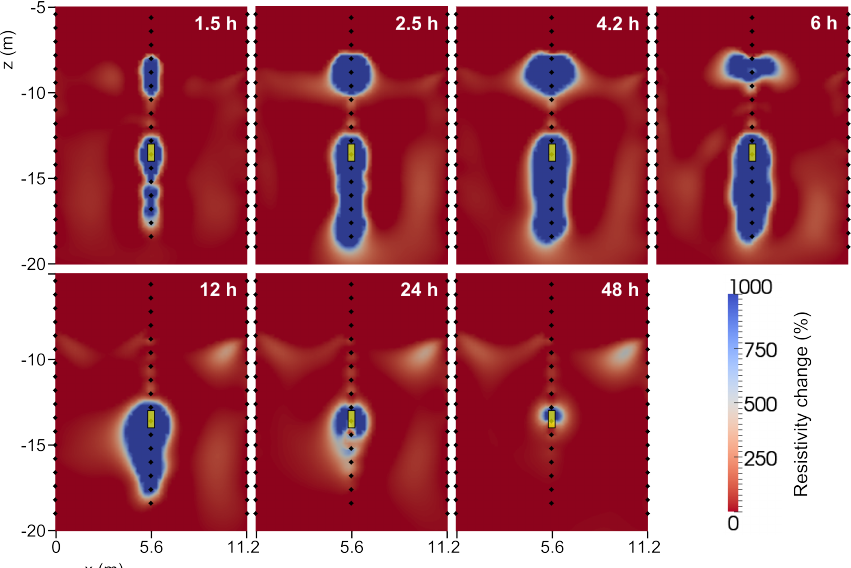
Figure 12. Results of synthetic ERT experiment for selected times (in hours after start of injection) for scenario 4 (see Table 2). Black diamonds denote the position of electrodes.